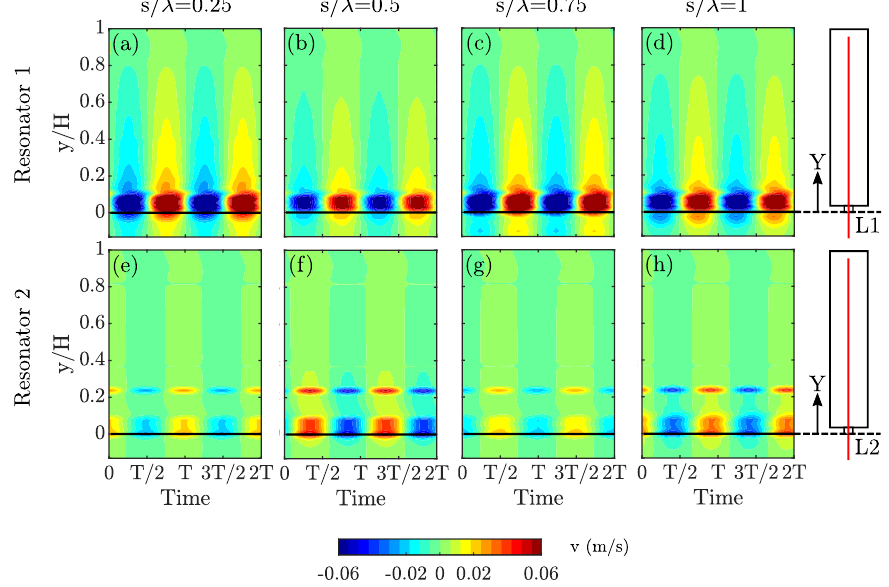
Figure 9. Contour plots of particle velocity for different spacing configurations between 0.25 < s / λ < 1. Top row: Particle velocity field within the first resonator for ( a ) s / λ = 0.25; ( b ) s / λ = 0.5; ( c ) s / λ = 0.75; ( d ) s / λ = 1; Bottom row: Particle velocity field within the second resonator for ( e ) s / λ = 0.25; ( f ) s / λ = 0.5; ( g ) s / λ = 0.75; ( h ) s / λ =